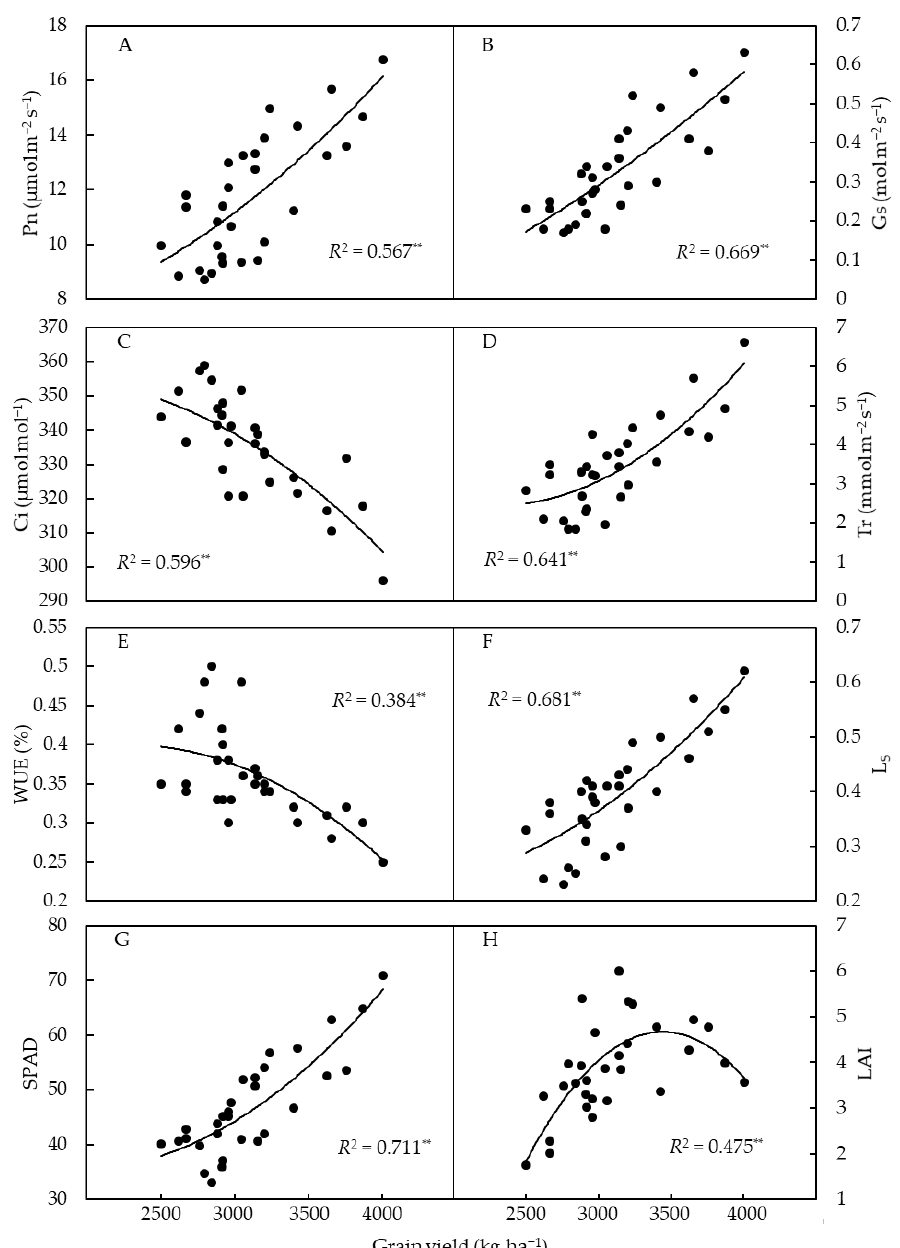
Figure 1. Relationships of grain yield with the net photosynthetic rate (Pn), stomatal conductance (Gs), intercellular CO 2 concentration (Ci), transpiration rate (Tr), water-use efficiency (WUE), stomatal limitation value (Ls), and leaf area index (LAI) of oat. Lines describe quadratic regression equations (y = a + bx − cx 2 ); ** significant correlation at p < 0.01.